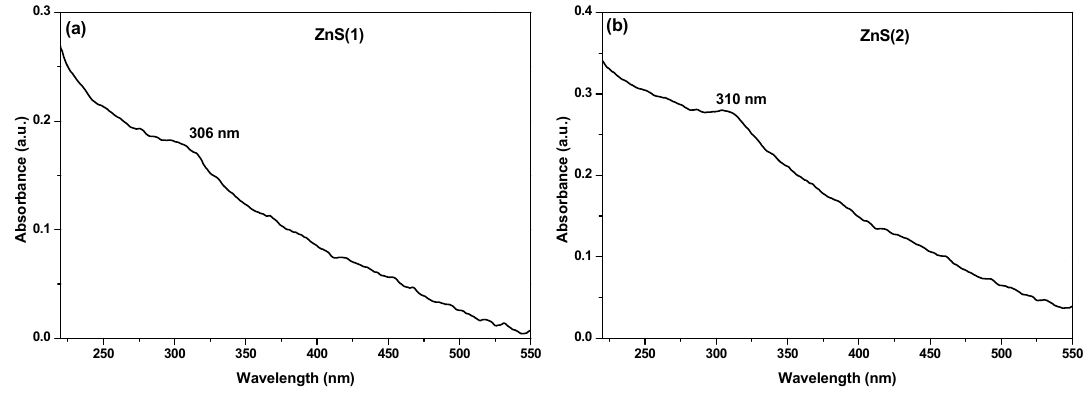
Figure 4. UV–Vis absorption spectra of samples ( a ) ZnS(1) and ( b ) ZnS(2). Table 1. Elemental analysis based on X-ray photoelectron spectroscopy (XPS) data for samples ZnS(1) and ZnS(2).